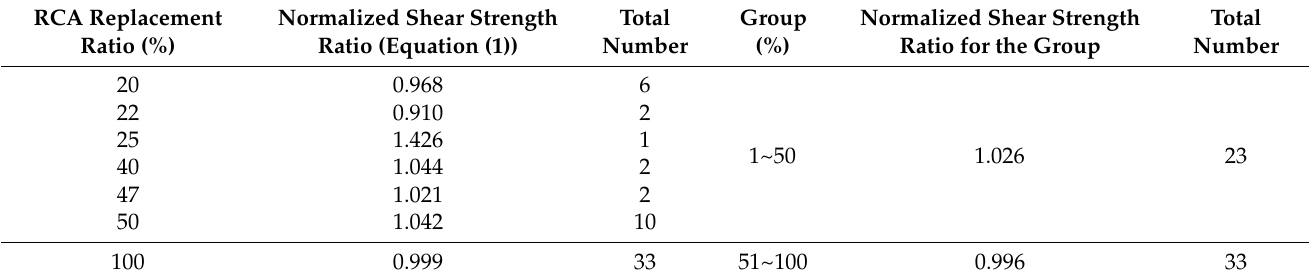
Table 2. Grouping of specimens with shear reinforcement according to RCA replacement